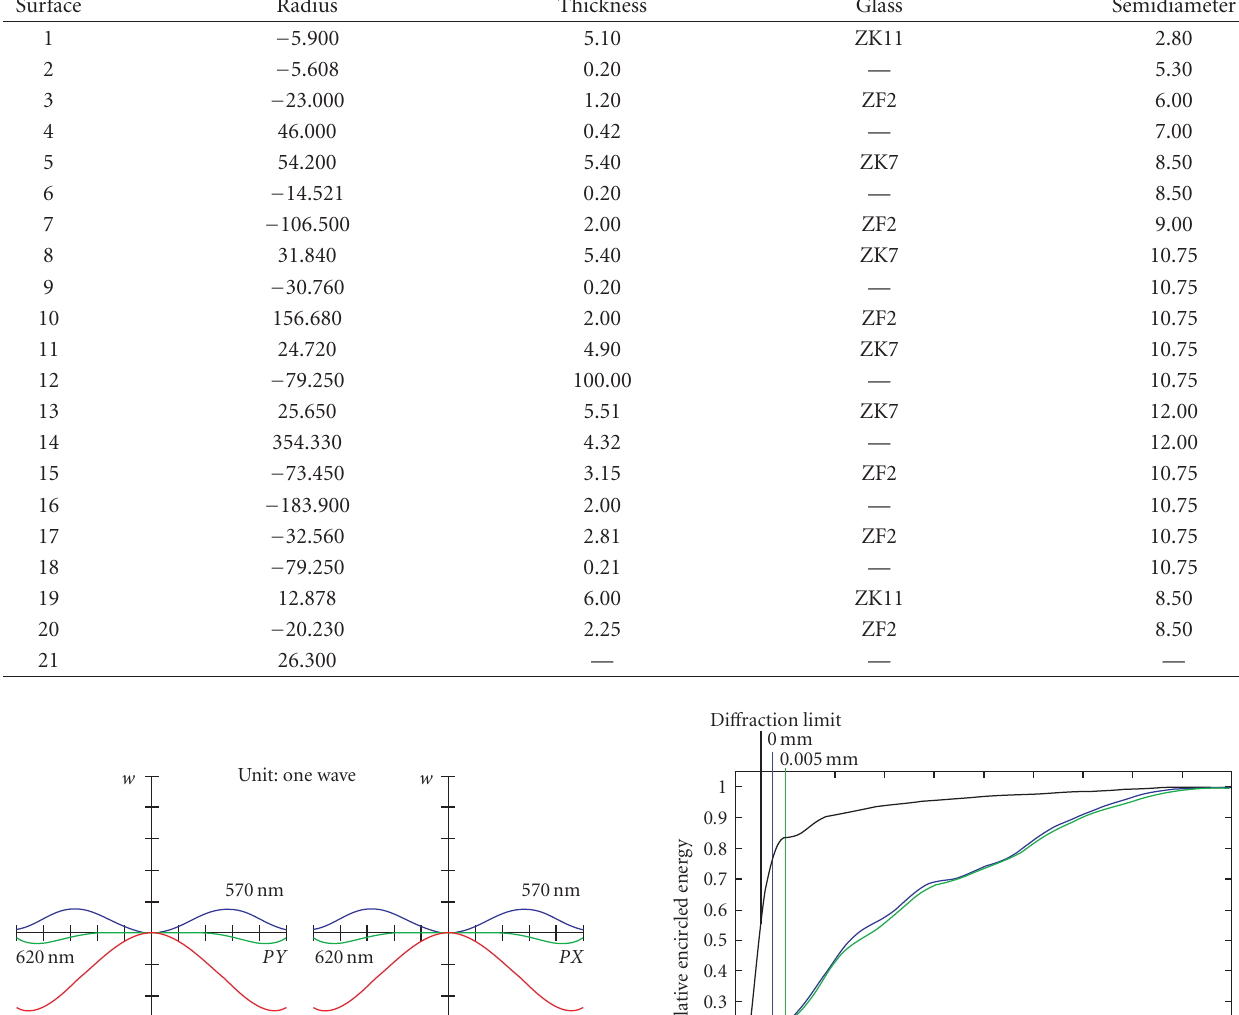
Table 1: The optimization data of confocal scanning system. Units are measured in mm.